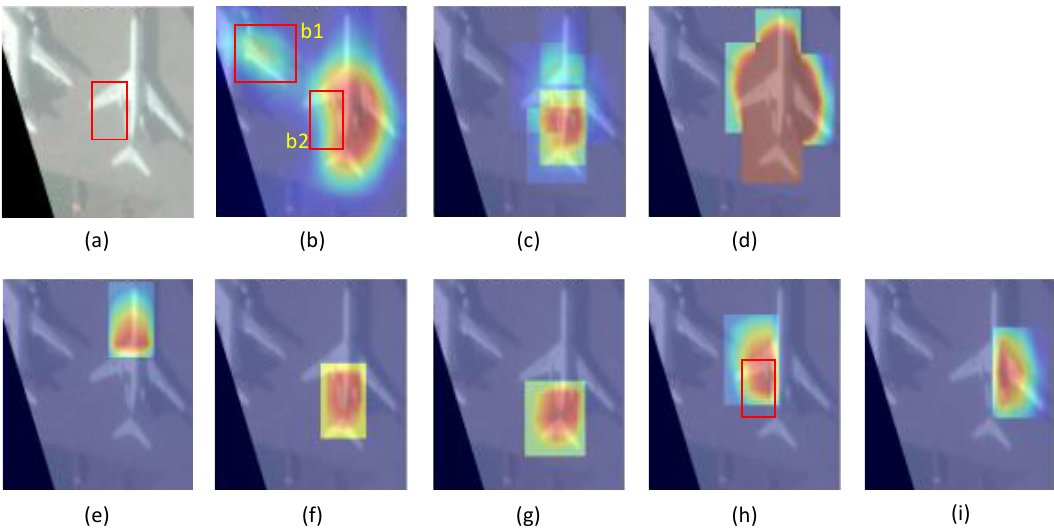
Figure 9. Heatmaps of aircraft Type43 before and after adding part feature fusion method. ( a ) original image, ( b ) heatmap corresponding to conv5_4 without part feature fusion, ( c ) the result after concatenation of the heatmap of each part, ( d ) the result after cutting off the heat value at the threshold, and ( e – i ) are the heatmaps of five parts,